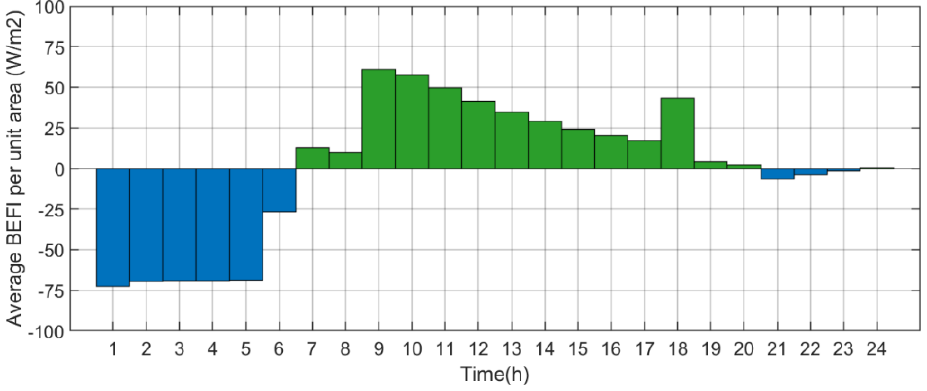
Figure 19. Average hourly BEFI (flexible control strategy).